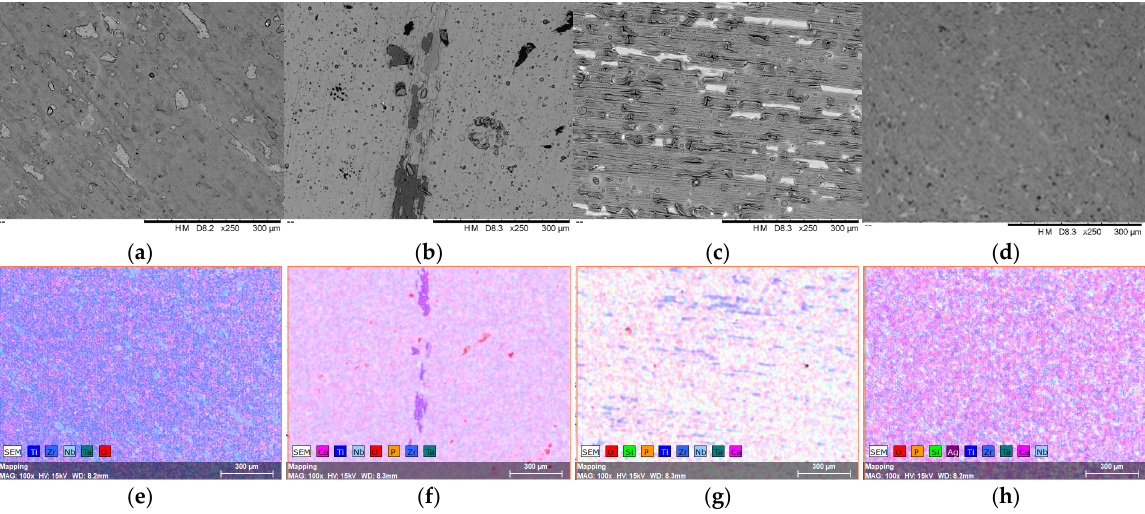
Figure 11. SEM and EDS images of: TNZT alloy ( a , e ), HA ( b , f ), SiC-HA ( c , g ) and Ag-SiC-HA ( d , h ) coatings.